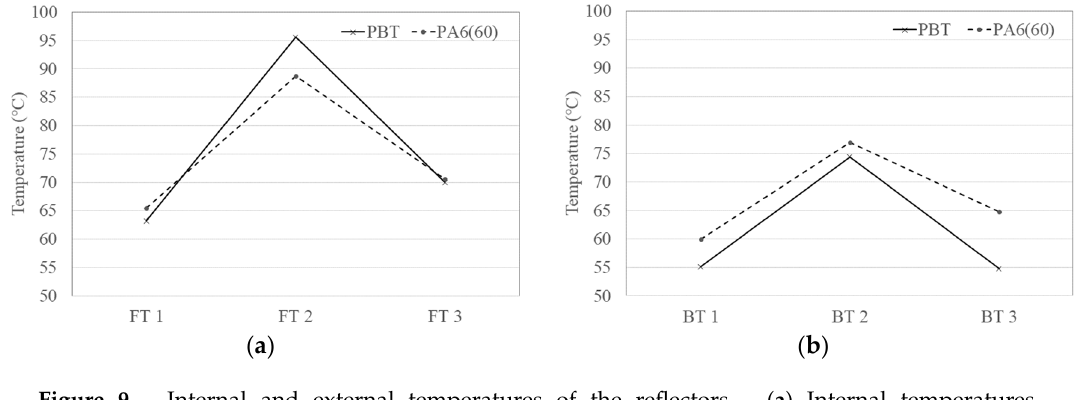
Figure 9. Internal and external temperatures of the reflectors. ( a ) Internal temperatures, ( b ) external temperatures.